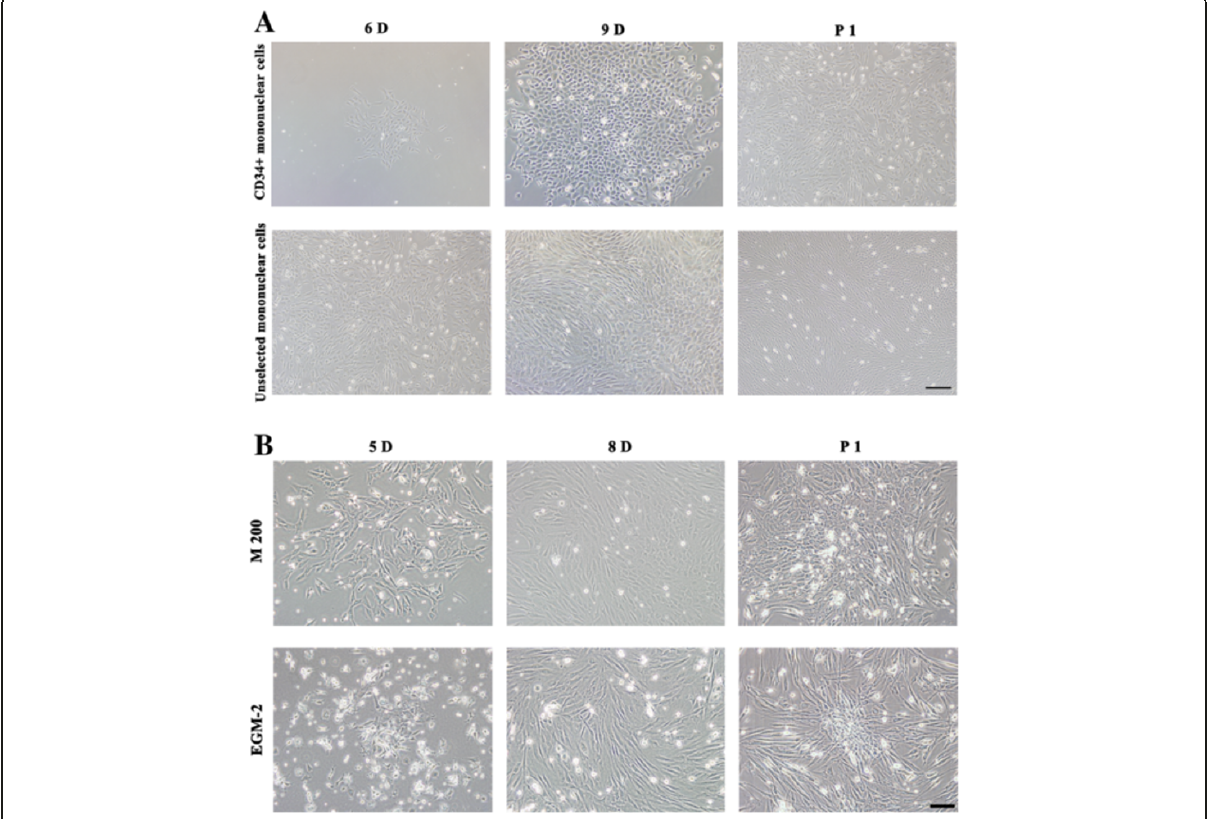
Figure 1 The morphology of EPCs isolated from Rhesus monkeys. A . Selected CD34+ mononuclear cells and unselected mononuclear cells were cultured in M 200, observed on day 6 (6D) or day 9 (9D) after culturing and day 4 after the first passage (P1). Both selected CD34+ and unselected mononuclear cells were cerioid shape on day 6, formed cobblestone-appearance colonies on day 9, and become more spindle shape with the loss of stereognosis after first passage. Bar =200 μ m. B . Unselected mononuclear cells were cultured in either M 200 or EGM-2 media, observed on day 5 (5D), day 8 (8D) after culturing and day 1 after the first passage (P1). Cells cultured in M 200 proliferated faster than in EGM-2, but cells in EGM-2 had better stereognosis. Bar =100 μ